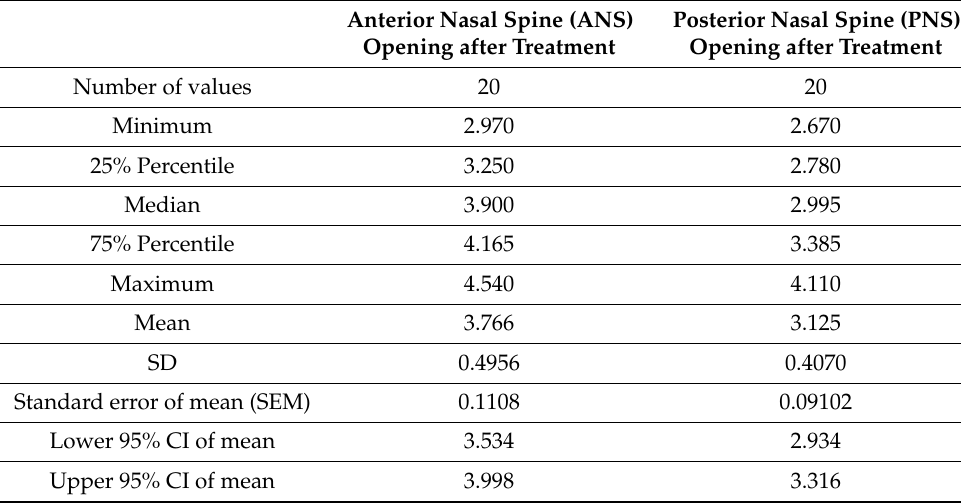
Table 1. The magnitude of the mid-palatal suture opening in millimeters.